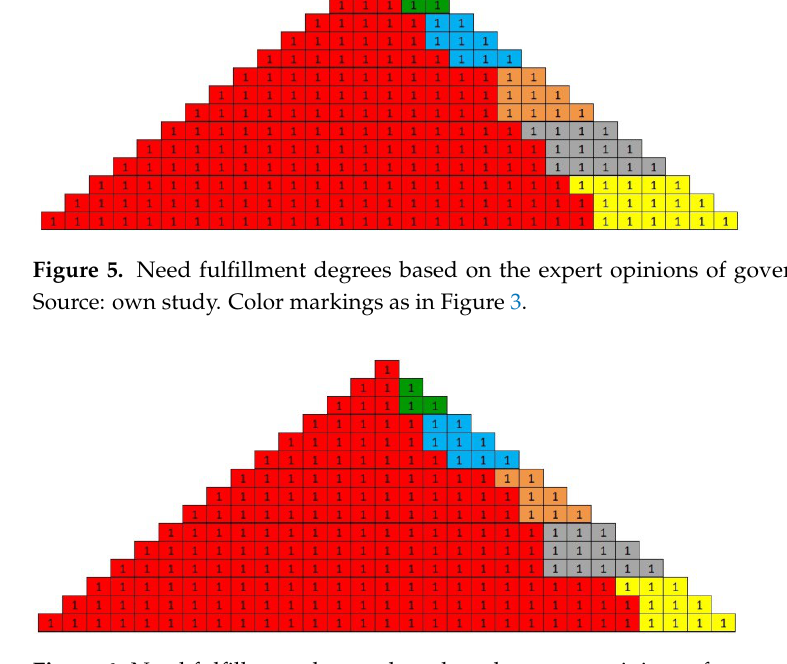
Figure 6. Need fulfillment degrees based on the expert opinions of state-own companies. Source: own study. Color markings as in Figure